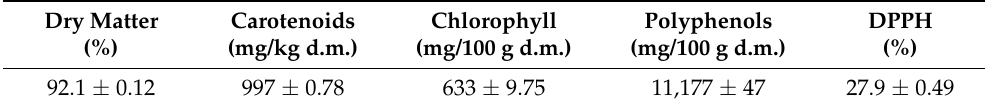
Table 1. Content of selected ingredients in sage.